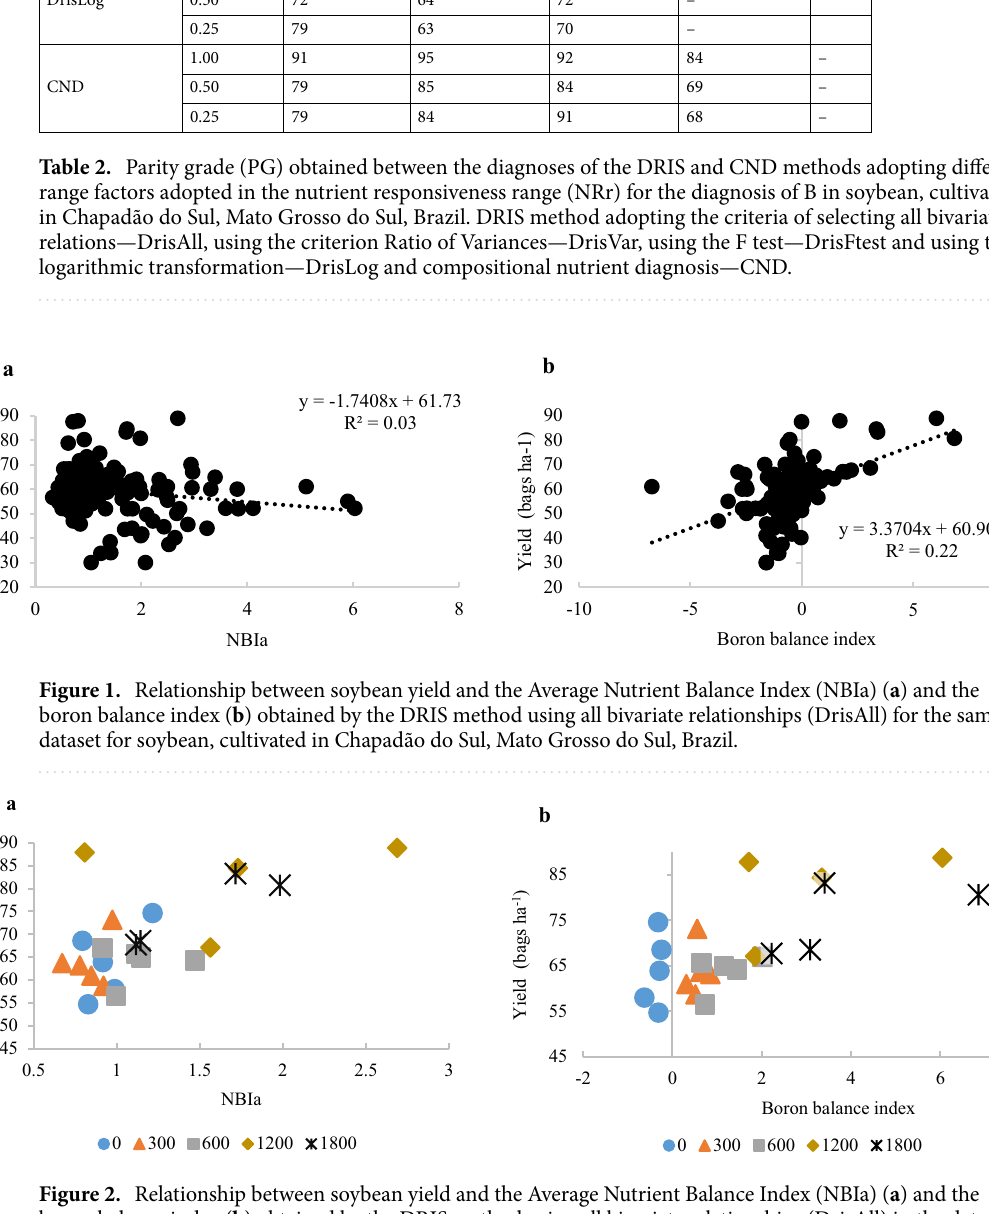
Figure 2. Relationship between soybean yield and the Average Nutrient Balance Index (NBIa) ( a ) and the boron balance index ( b ) obtained by the DRIS method using all bivariate relationships (DrisAll) in the dataset of the calibration experiment of B in soybean (doses 0, 300, 600, 1200, and 1800 kg ha −1 of B), cultivated in Chapadão do Sul, Mato Grosso do Sul,